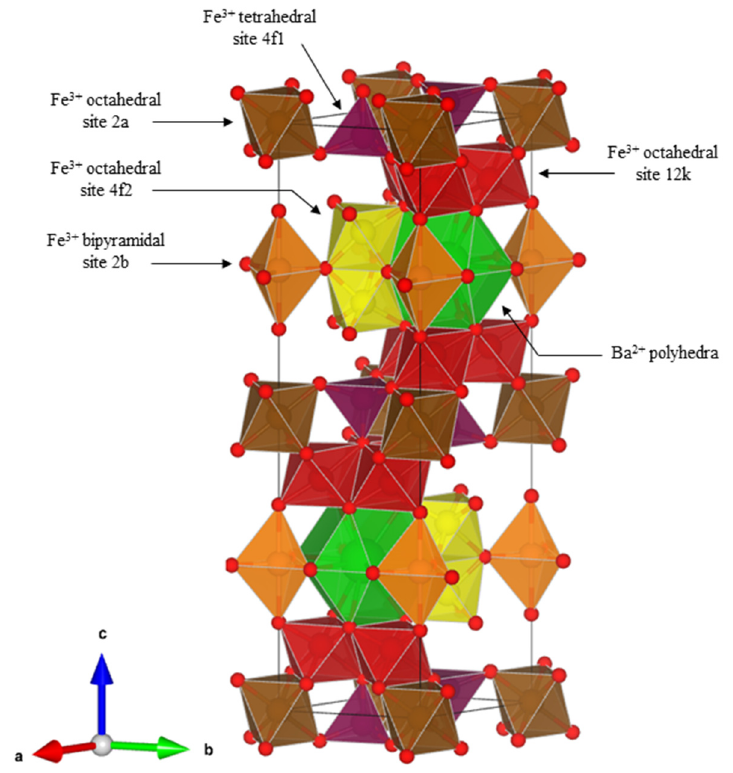
Figure 3. Crystal structure of the BaFe 12 O 19 hexagonal ferrite.